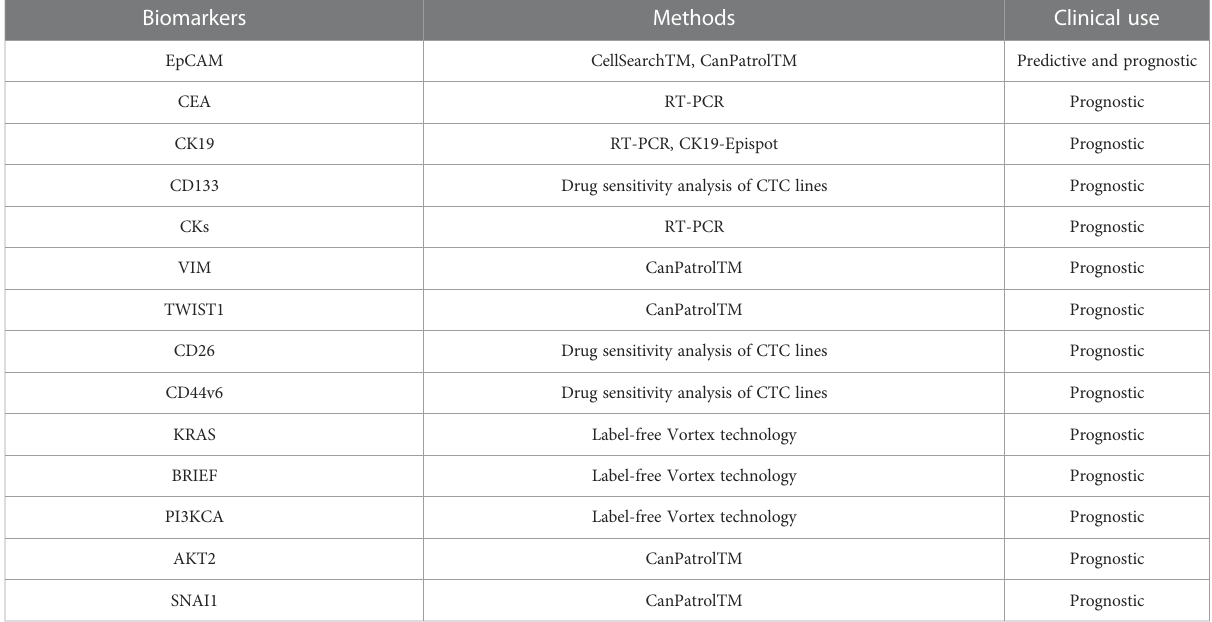
TABLE 1 List of CTCs biomarkers and its clinical use in